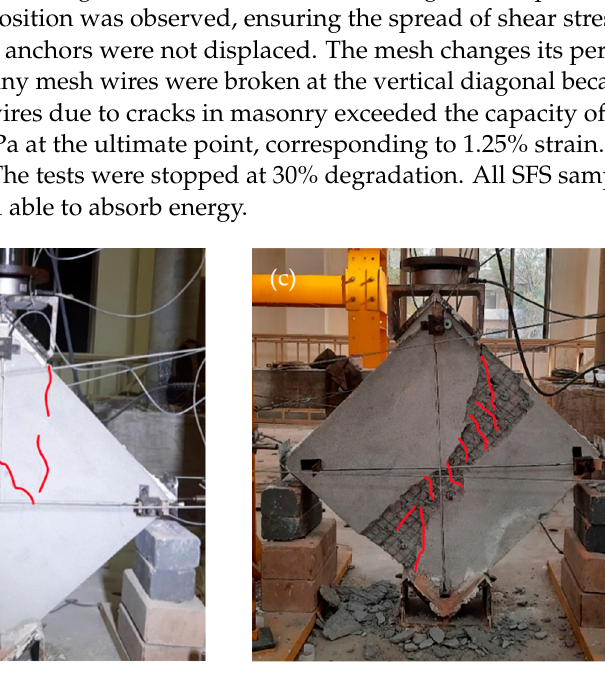
Figure 11. Failure pattern of SFS-reinforced specimens.